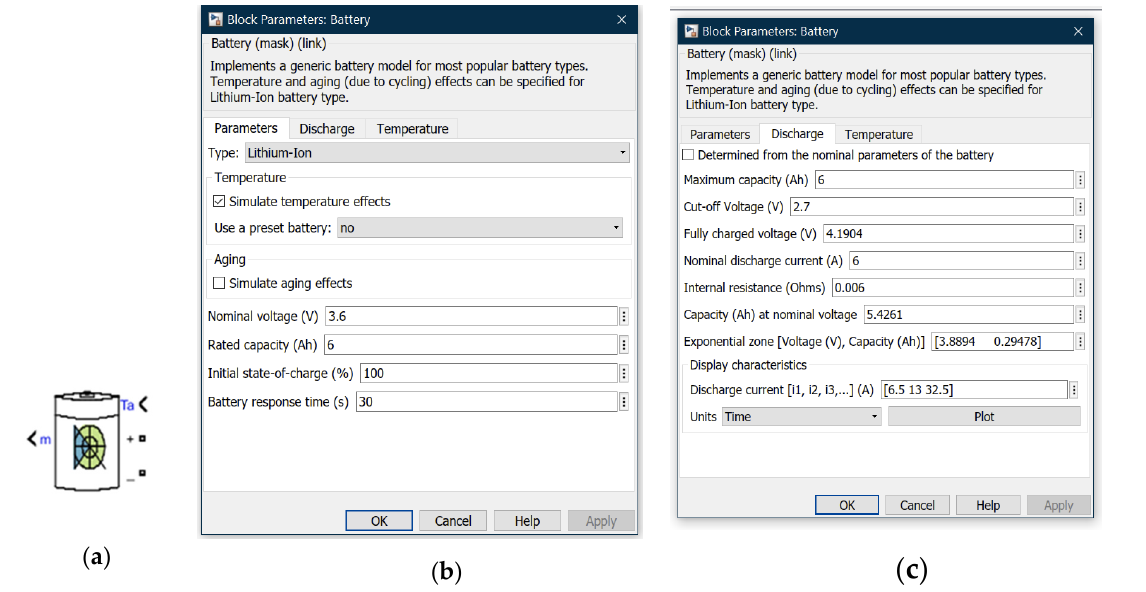
Figure 16. SAFT Li-ion battery specification—Simscape model; ( a ) Simscape model graphic representation (icon); ( b ) block parameters and battery type; ( c ) block parameters’ battery specification for a discharging constant current.